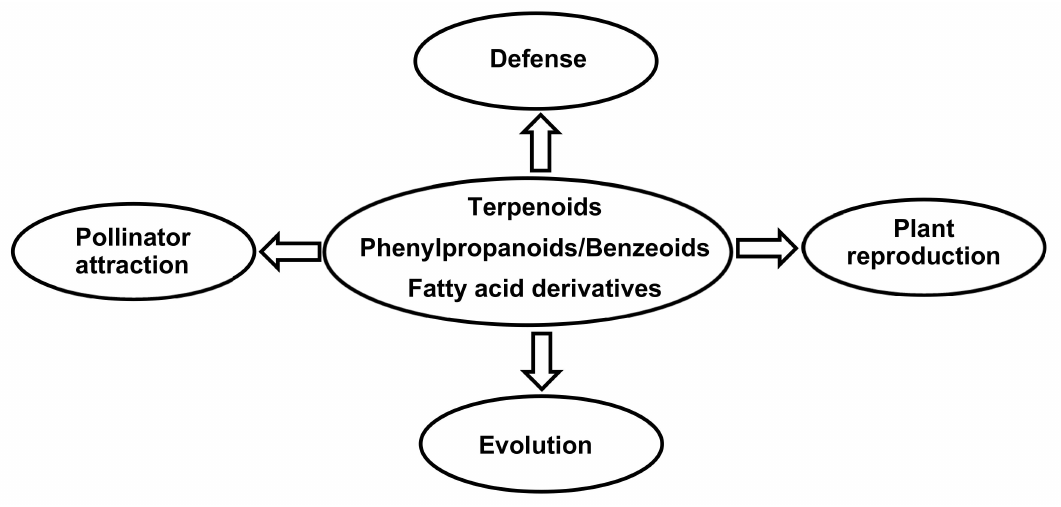
Figure 2. Functions of floral volatiles in orchid